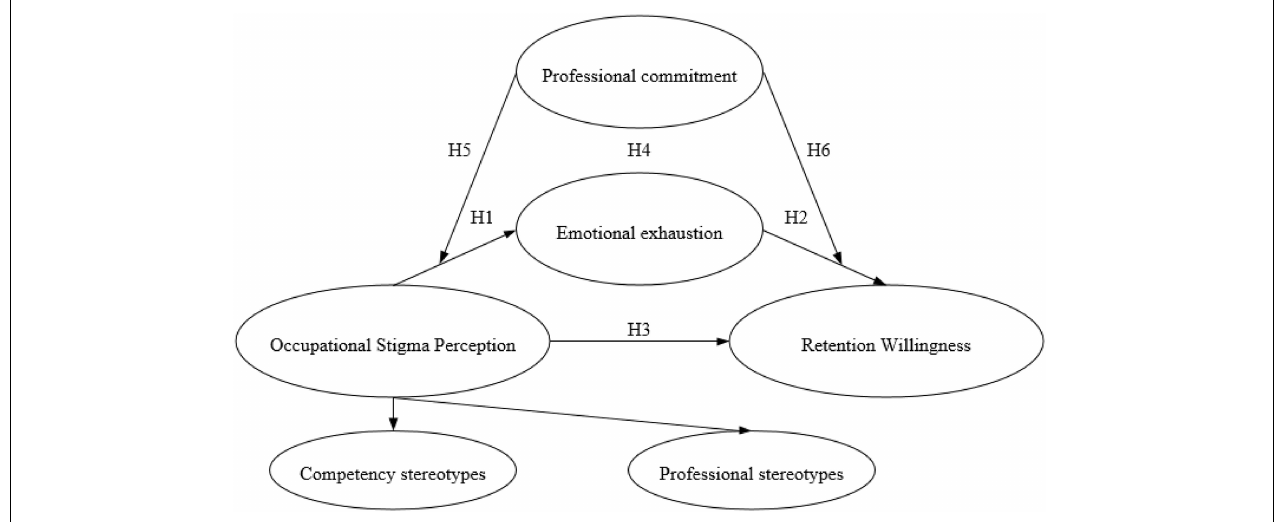
FIGURE 2 | Hypothesis and content framework of this